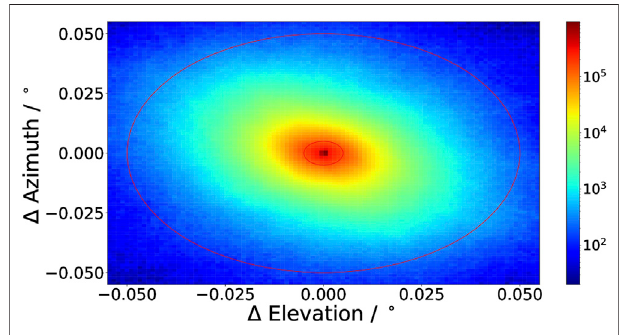
FIGURE 3 | Angular departures (in perpendicular azimuth and elevation directions) of the solar tracker mirrors from the setpoint position throughout the RV Mirai cruise for all measurements where the solar tracker was in fi ne- tracking mode. Colors indicate (logarithmic) occurrence and red circles indicate tracking precisions of 0.05 ° and 0.005 °